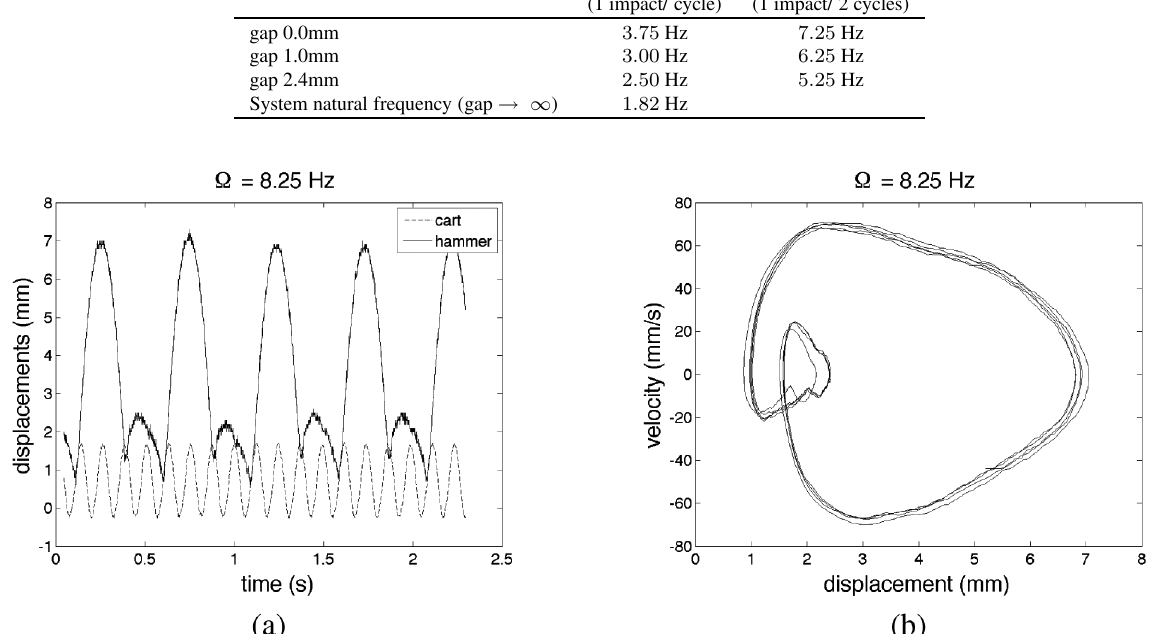
Fig. 8. Gap 0.0 mm. System undergoes a bifurcation. Excitation frequency 8.25 Hz: a) Displacements; b) Hammer phase plane.